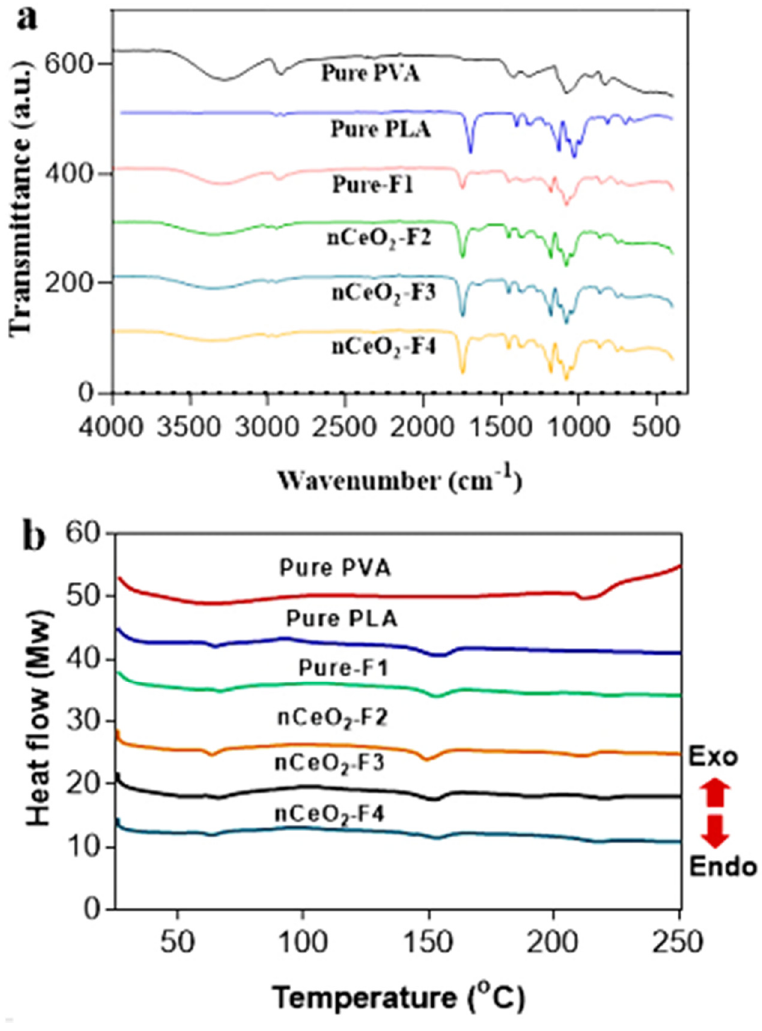
Figure 5. FTIR spectra ( a ) and DSC thermograms ( b ) of the nanofibrous membranes under